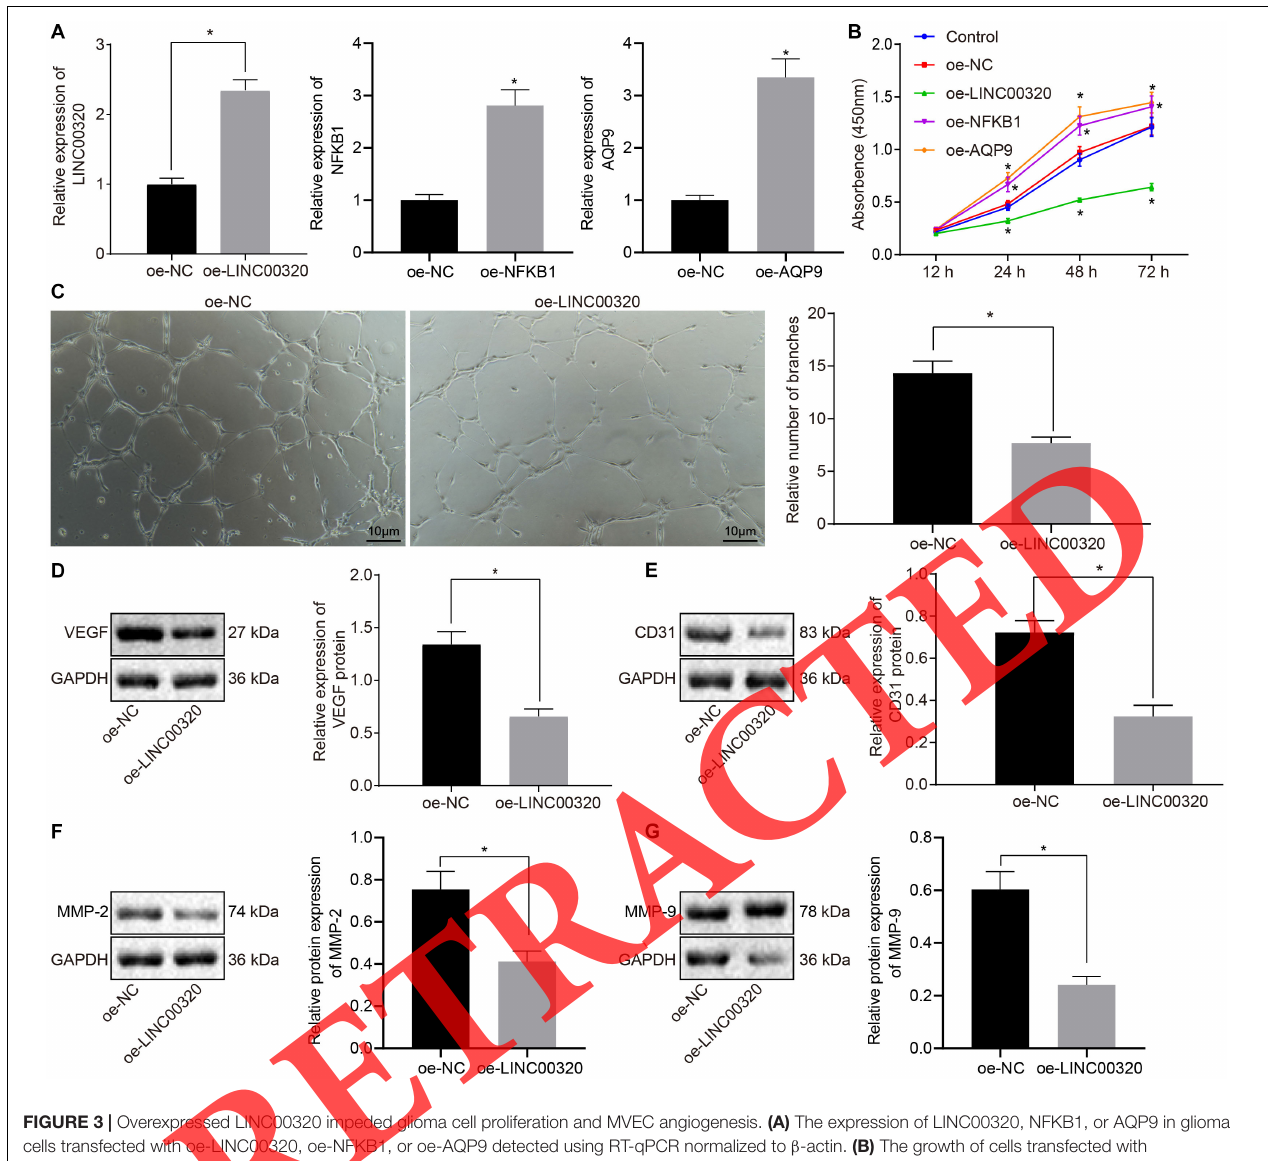
FIGURE 3 | Overexpressed LINC00320 impeded glioma cell proliferation and MVEC angiogenesis. (A) The expression of LINC00320, NFKB1, or AQP9 in glioma cells transfected with oe-LINC00320, oe-NFKB1, or oe-AQP9 detected using RT-qPCR normalized to β -actin. (B) The growth of cells transfected with oe-LINC00320 measured using CCK-8 assay. (C) The cellular tube formation in MVECs upon co-culture with glioma cells transfected with oe-LINC00320 (100 × ; scale bar = 10 µ m). (D) Expression of angiogenesis-related VEGF protein in MVECs upon co-culture with glioma cells transfected with oe-LINC00320 normalized to GAPDH measured by Western blot analysis. (E) Expression of angiogenesis-related CD31 protein in MVECs upon co-culture with glioma cells transfected with oe-LINC00320 normalized to GAPDH measured by Western blot analysis. (F) Expression of angiogenesis-related MMP-2 protein in MVECs upon co-culture with glioma cells transfected with oe-LINC00320 normalized to GAPDH measured by Western blot analysis. (G) Expression of angiogenesis-related MMP-9 protein in MVECs upon co-culture with glioma cells transfected with oe-LINC00320 normalized to GAPDH measured by Western blot analysis. * p < 0.05 vs. cells transfected with oe-NC. Data were expressed as mean ± standard deviation and data between two groups were analyzed by independent-sample t test. Data between two groups at different time points were compared by repeated-measures ANOVA. The experiment was repeated three times